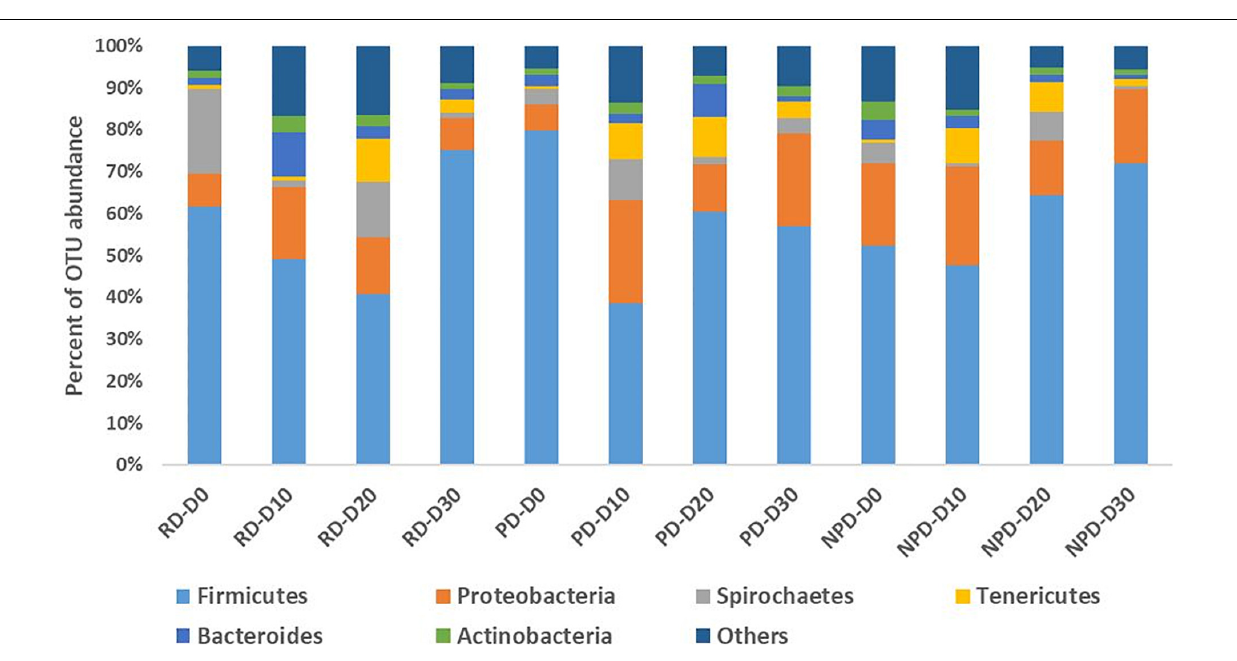
FIGURE 2 | Relative abundance of bacterial taxa in the gut of rainbow trout at different time intervals (after excluding operational taxonomic unit OTU1 and OTU2, belonging to Mycoplasma ) ( n = 5). RD: reference diet, PD: preconditioned (heat-processed) diet, NPD: non-preconditioned diet. D0, D10, D20, and D30 refer to the 10-day time interval. Until day 0, all fish had been fed a commercial diet for 10